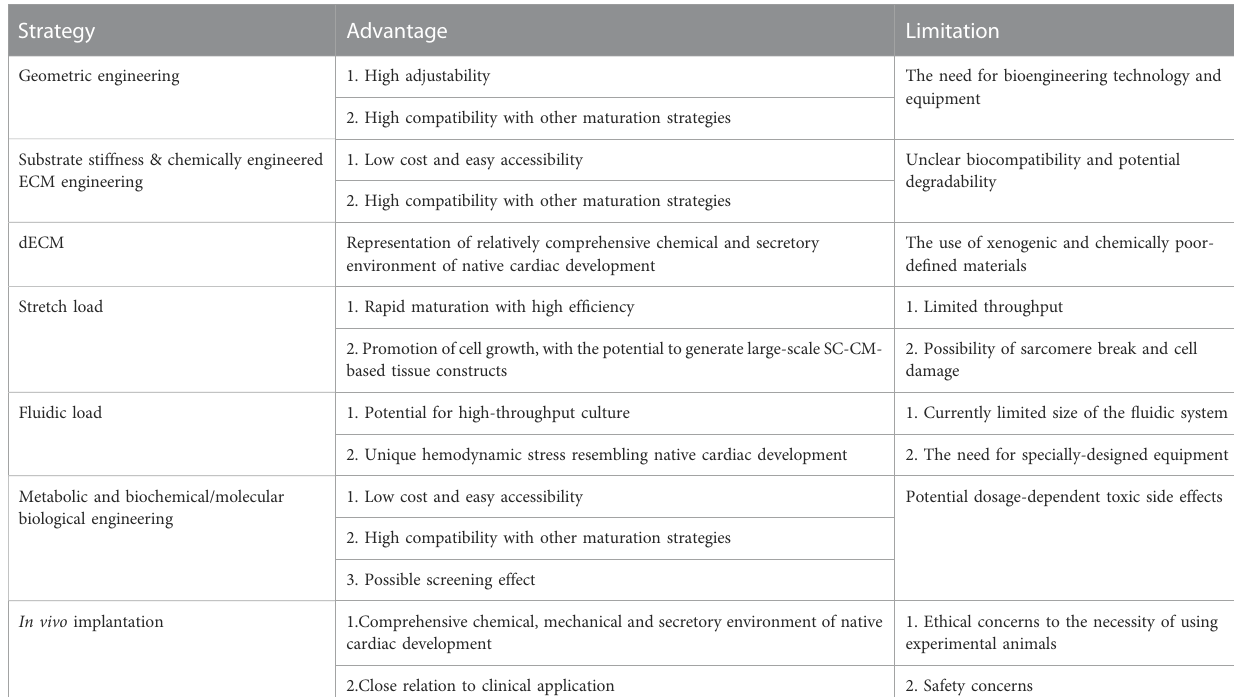
TABLE 4 Major advantages and limitations of several maturation